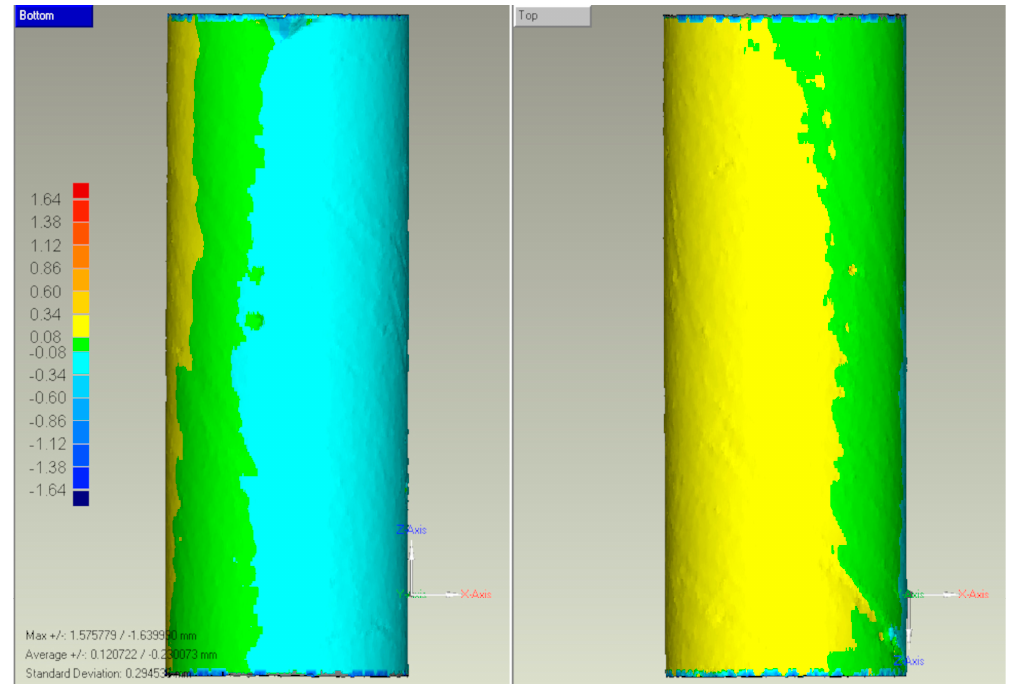
Figure 6. Example 3D surface deviations map of examined gypsum counter-sample from the cylin- drical